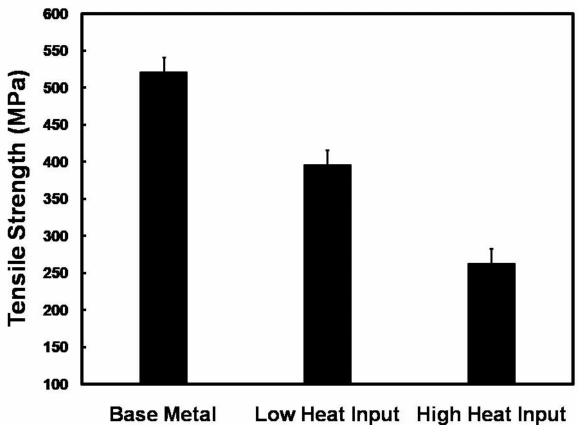
Figure 14. Tensile strength of the low and high heat input welds both with that of the